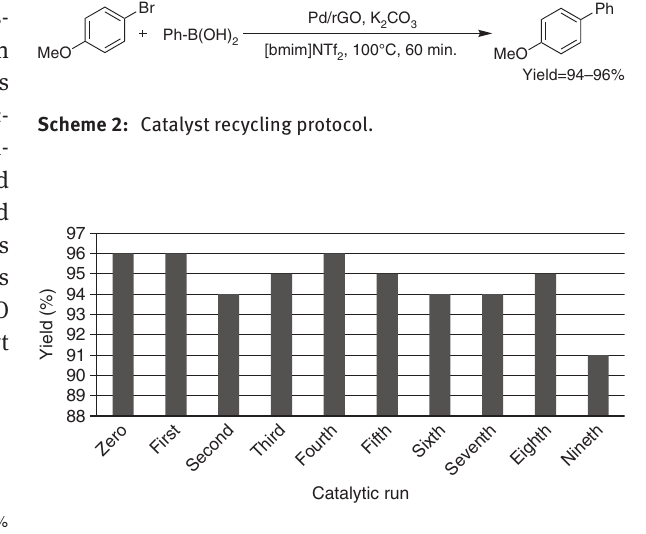
Figure 3: Recycling results of Pd/reduced graphene oxide (rGO)/ [bmim]NTf for Suzuki reaction. Scheme 1: Suzuki model reaction for catalyst optimization. 2